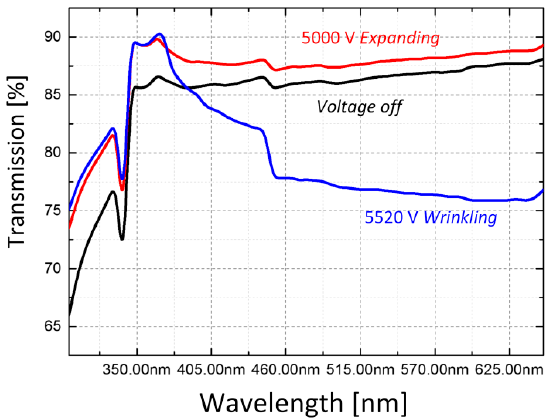
Figure 8. The optical transparency in the hydrogel is actuated by the voltage from flat to wrinkled state and transmission visible spectra are measured in the three actuation states.